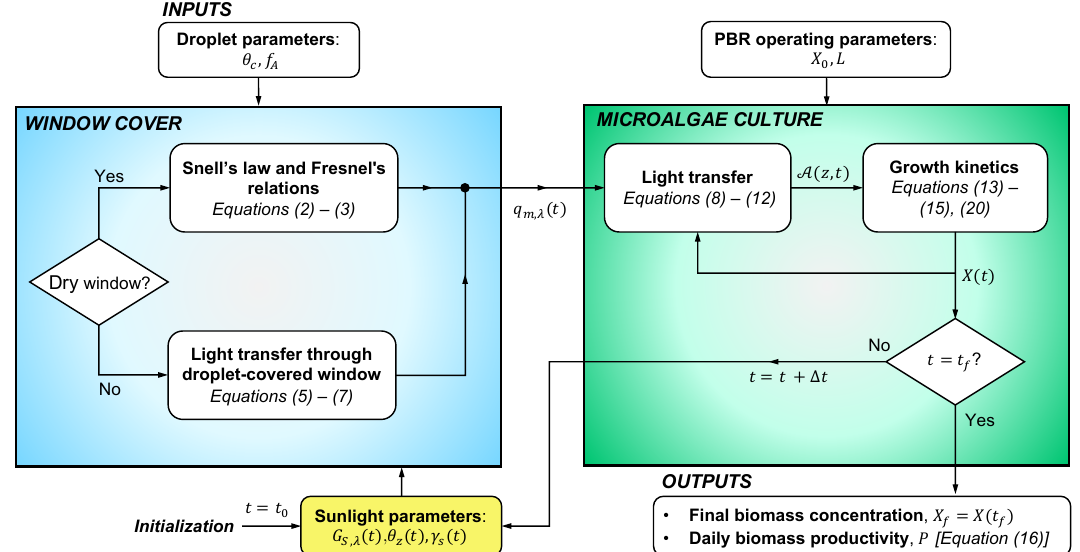
Figure 4. Block diagram of the procedure used to predict the final daily biomass X f and daily areal biomass productivity P for PBRs with dry and droplet-covered